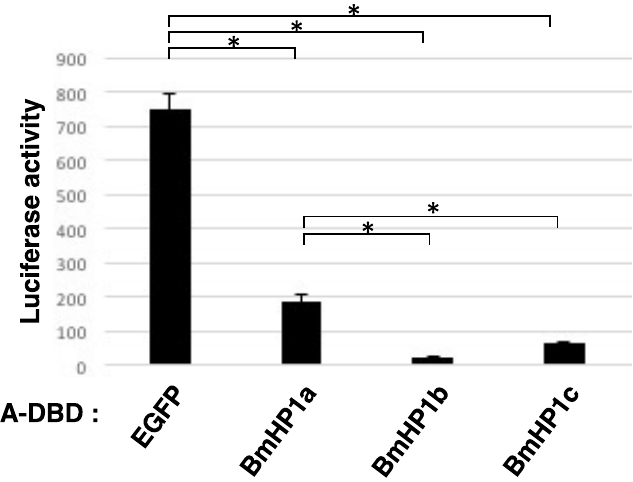
Figure 2. Transcription repression assay. DBD fused protein expression plasmid and luciferase reporter plasmid were co-transfected into BmN4 cells. After 5 days, the cells were collected and the luciferase activity was measured to evaluate the transcription repression activity of BmHP1 s. Error bars = standard deviation ( n = 3). “*” indicates a significant difference at p < 0.05 (Tukey test). 3.3. BmHP1c Does Not Form Homo- and Heterodimers with the Other BmHP1s